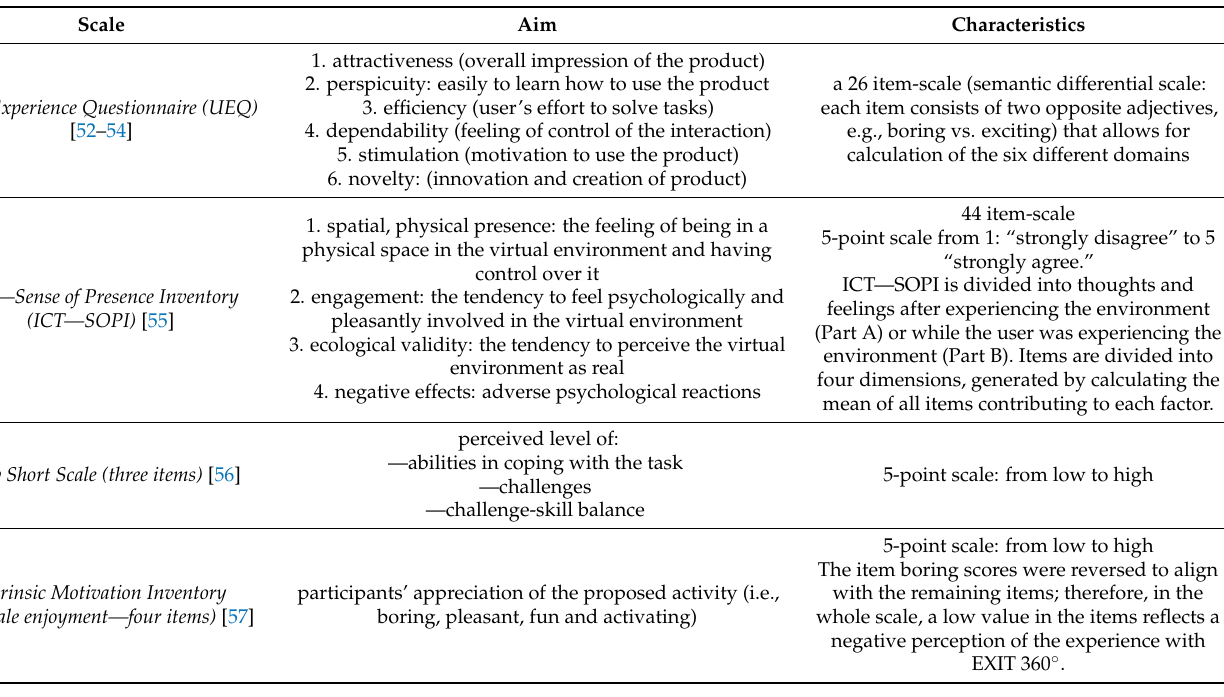
Table 1. Questionnaire and scale to evaluate the user